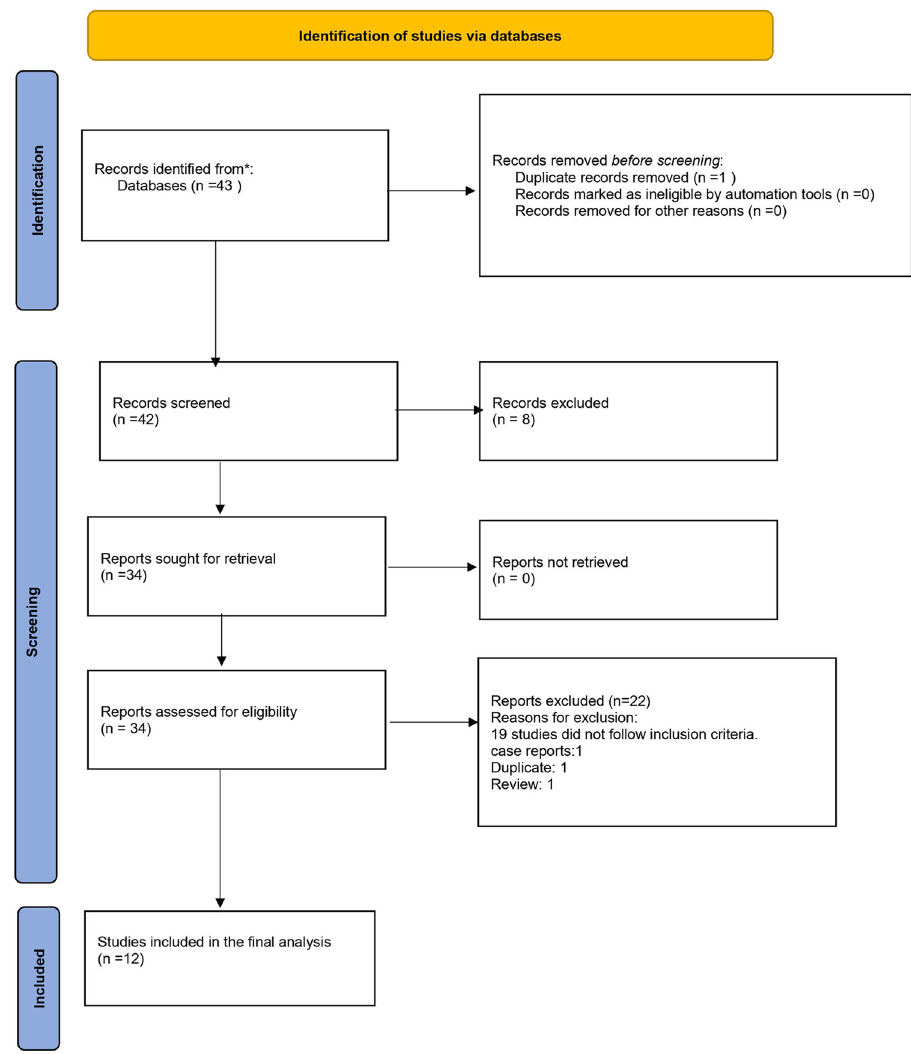
Fig. 1 Preferred Reporting Items for Systematic Reviews and Meta-Analyses(PRISMA) fl ow diagram. An evidence-based minimum set of items for reporting in systematic reviews and